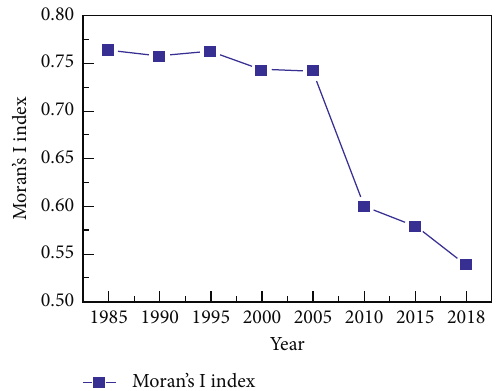
Figure 6: Variation in Moran’s index in the central urban area of the study area.